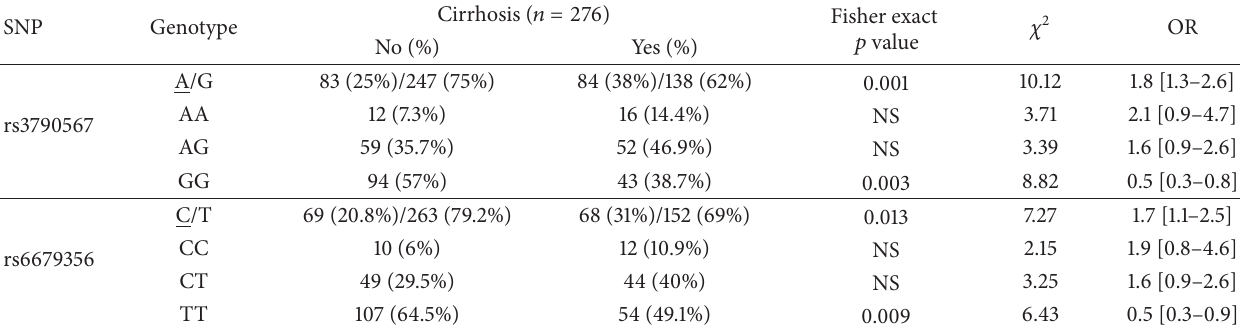
Table 3: The IL12RB2 polymorphisms (rs3790567, rs6679356) association with cirrhosis in PBC.